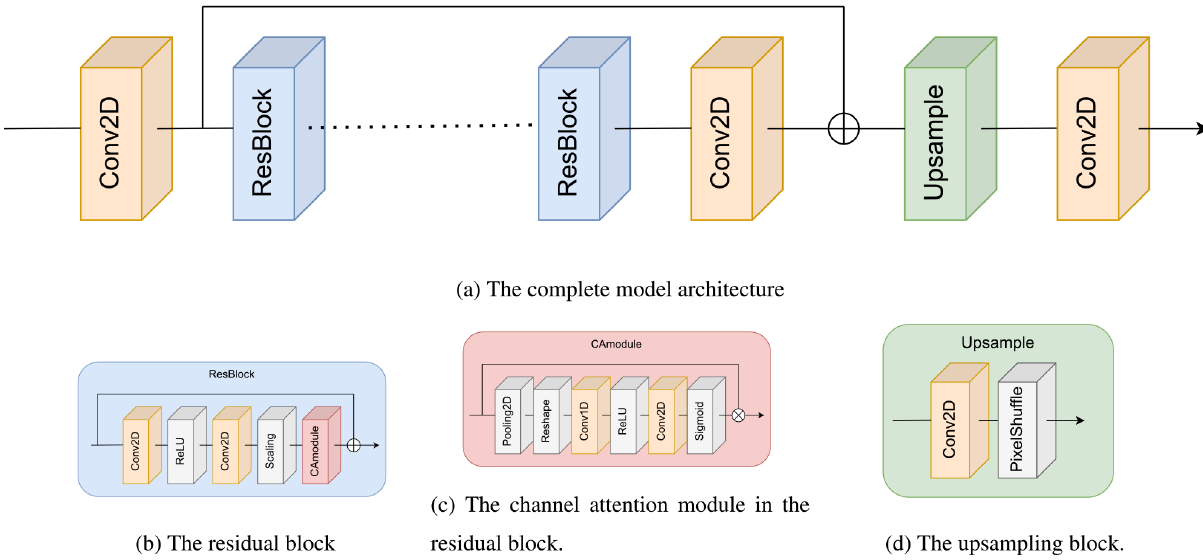
Figure 1. The overall layout of the neural network model (a) consists of an upsampling block (d) and residual blocks (b) , which again contain a channel attention module (c) . Here, ⊕ means adding the layers and ⊗ means multiplying them. The dotted line indicates that the residual block (b) is repeated multiple